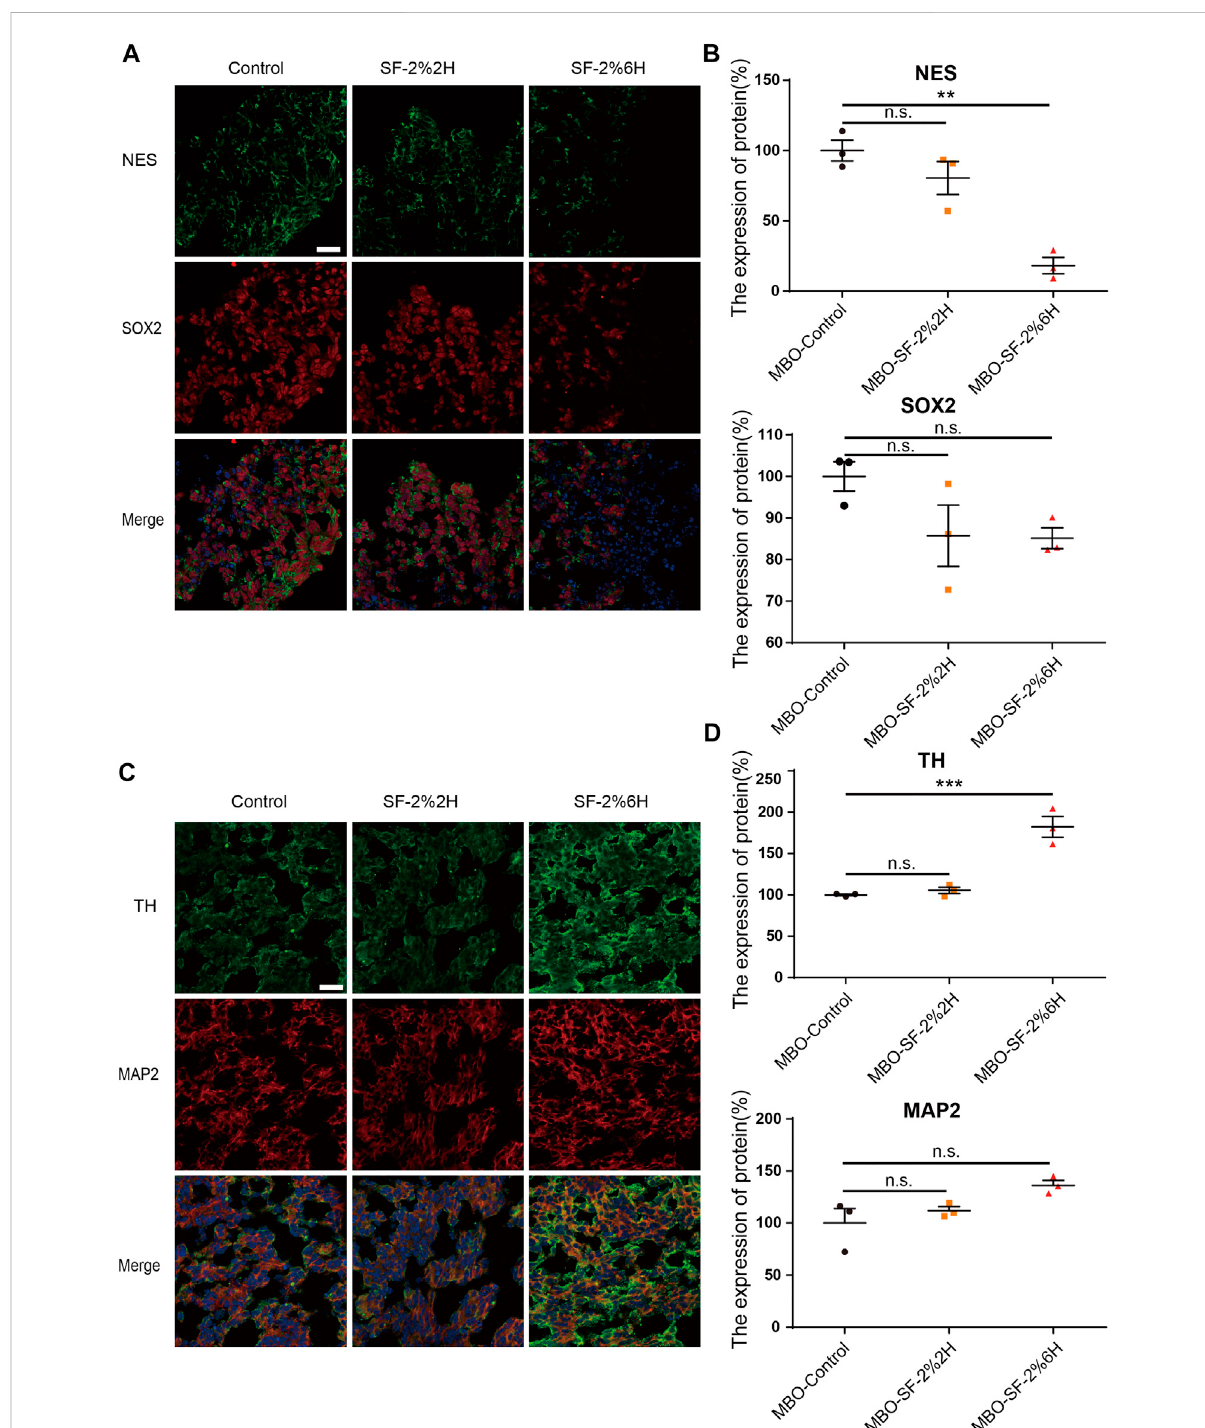
FIGURE 7 Sevo fl urane promotes the early differentiation of hMBOs. (A) Sample images of hMBOs after 3 days of sevo fl urane stimulation and immuno fl uorescence staining for NES (green), SOX2 (red) and DAPI (blue). (B) Quanti fi cation of NES (n = 3). (C) Quanti fi cation of SOX2 (n = 3). (D) Sample images of hMBOs after 20 days of sevo fl urane stimulation and immuno fl uorescence staining for TH (green), MAP2 (red) and DAPI (blue). (E) Quanti fi cation of TH (n = 3). (F) Quanti fi cation of MAP2 (n =